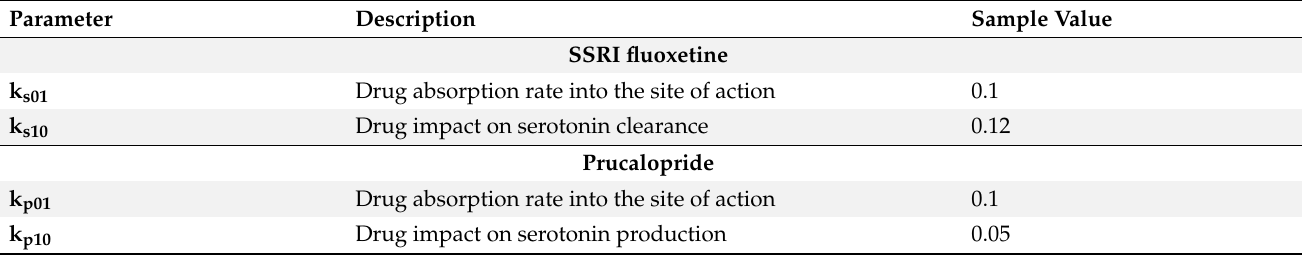
Table A2. Additional parameters to describe qualitative drug dynamics and their impact on the ENS as reported in [13]. The values reported in this table capture the quanlitative dynamics of these drugs and are not calibrated for quantitative